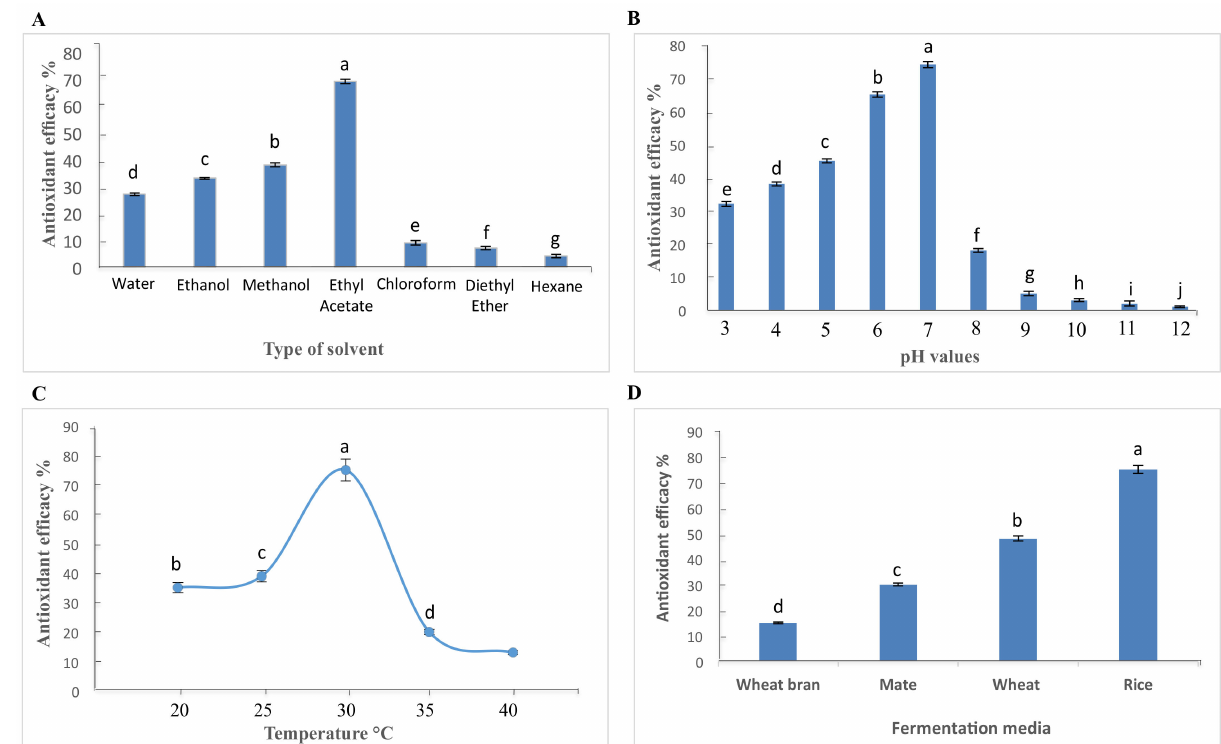
Figure 1. ( A ) Effect of using different solvents on the effectiveness of antioxidant compounds of fermented rice (koji) inoculated with A. flavus following 15-days of incubation at 30 ◦ C. ( B ) Effect of different pH values on the effectiveness of antioxidant compounds of fermented rice (koji) inoculated with A. flavus following 15-days of incubation at 30 ◦ C. ( C ) Effect of different temperatures on the effectiveness of antioxidant compounds. Compounds of fermented rice (koji) inoculated with A. flavus following 15-days of incubation at pH 7. ( D ) Effect of different fermentation media on the effectiveness of antioxidant compounds of fermented rice (koji) inoculated with A. flavus following 15-days of incubation at 30 ◦ C. * The different letters indicate significant differences at the probability level p < 0.05.